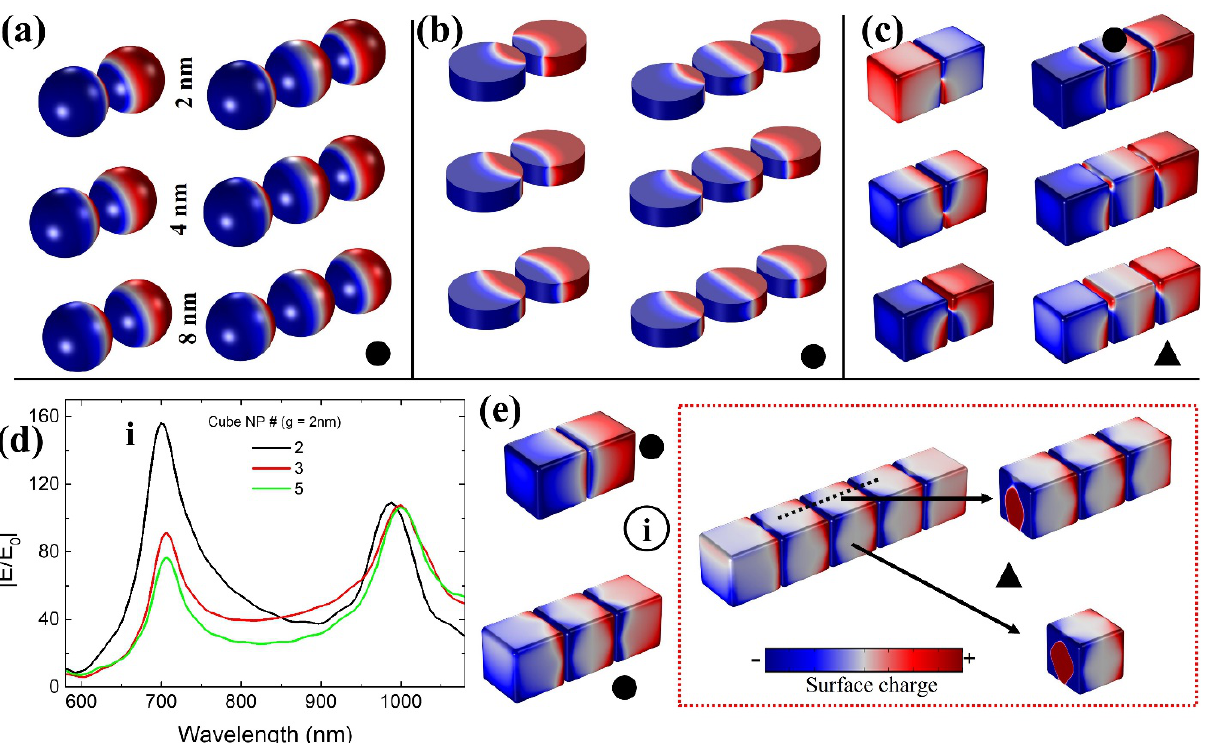
Figure 4. Simulated 3DSCM profiles taken from dimer and trimer nanostructures with different gap sizes for NP shapes of a sphere ( a ), disk ( b ), and cube ( c ). Solid circle (dipole) and triangle (quadrupole) symbols represent the plasmonic modes. All 3DSCM profiles are arranged in order of following gap size of 2 nm, 4 nm, and 8 nm. ( d ) Broadband |E/E 0 | spectra taken from cube nanostructures with increasing NP numbers from two to five and respective ( e ) 3DSCM profiles extracted from the position marked as “i”.